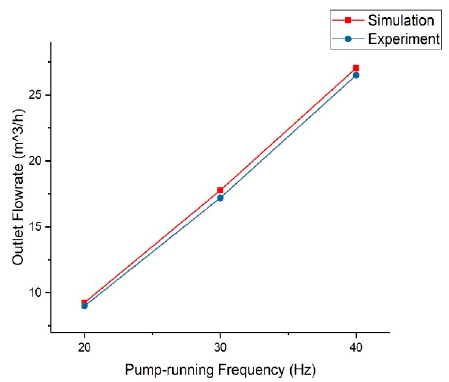
Figure 7. Comparison of the outlet flow rates obtained by the simulation and experiment.